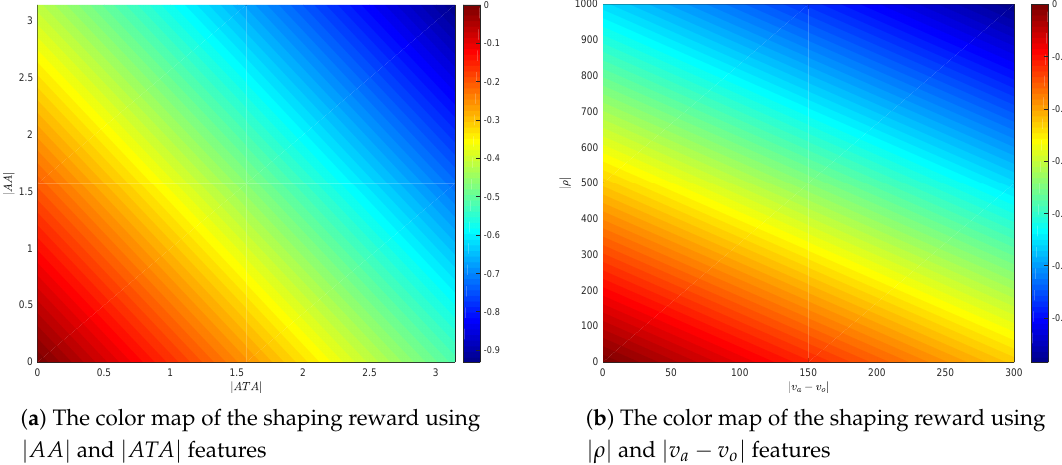
( a ) The color map of the shaping reward using | AA | and | ATA | features Figure 8. The effects of the 4 features of the aerial combat on the shaping